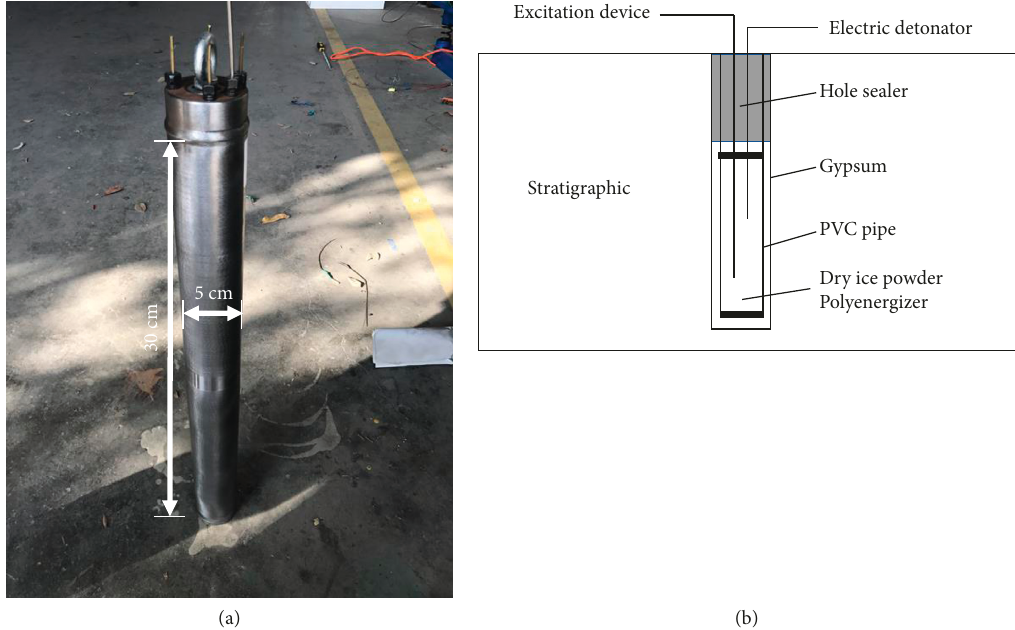
Figure 3: CO 2 fracturing vessel and principle. (a) Physical image of the fracturing vessel. (b) Fracturing principle diagram.